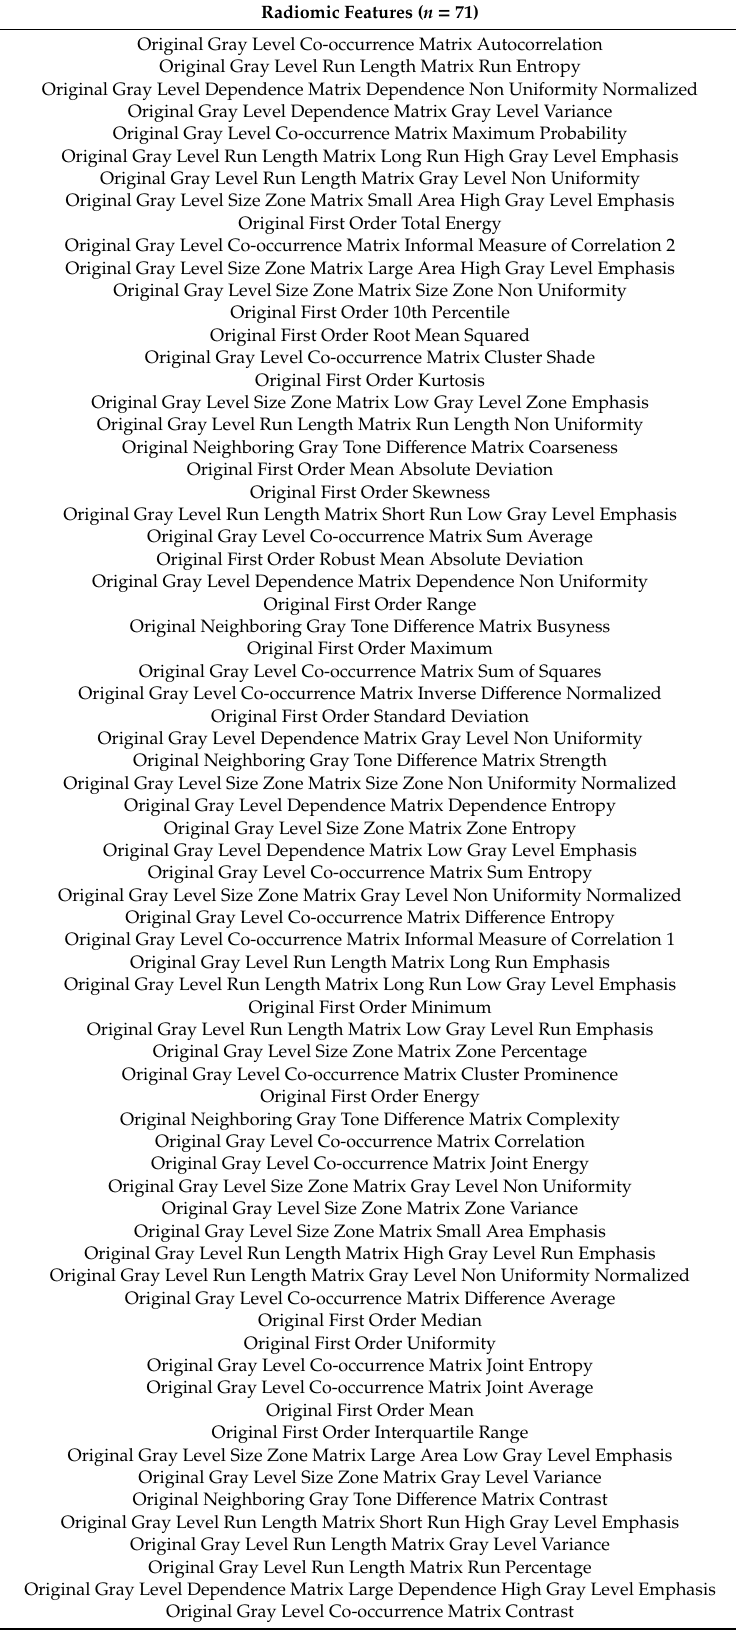
Table A4. Final Features Used by DWI XGBoost Model Ranked By